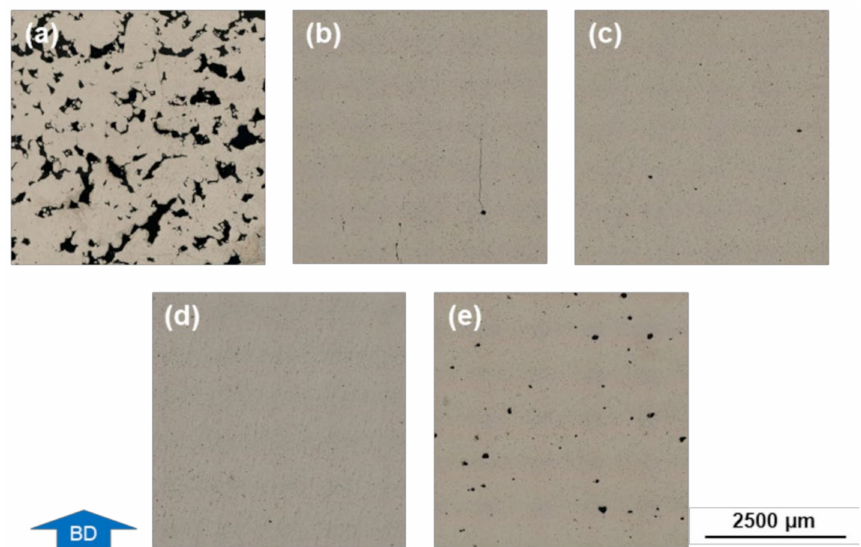
Figure 6. Micrographs of cross-sectional cuboid samples taken with a digital microscope. PBF-